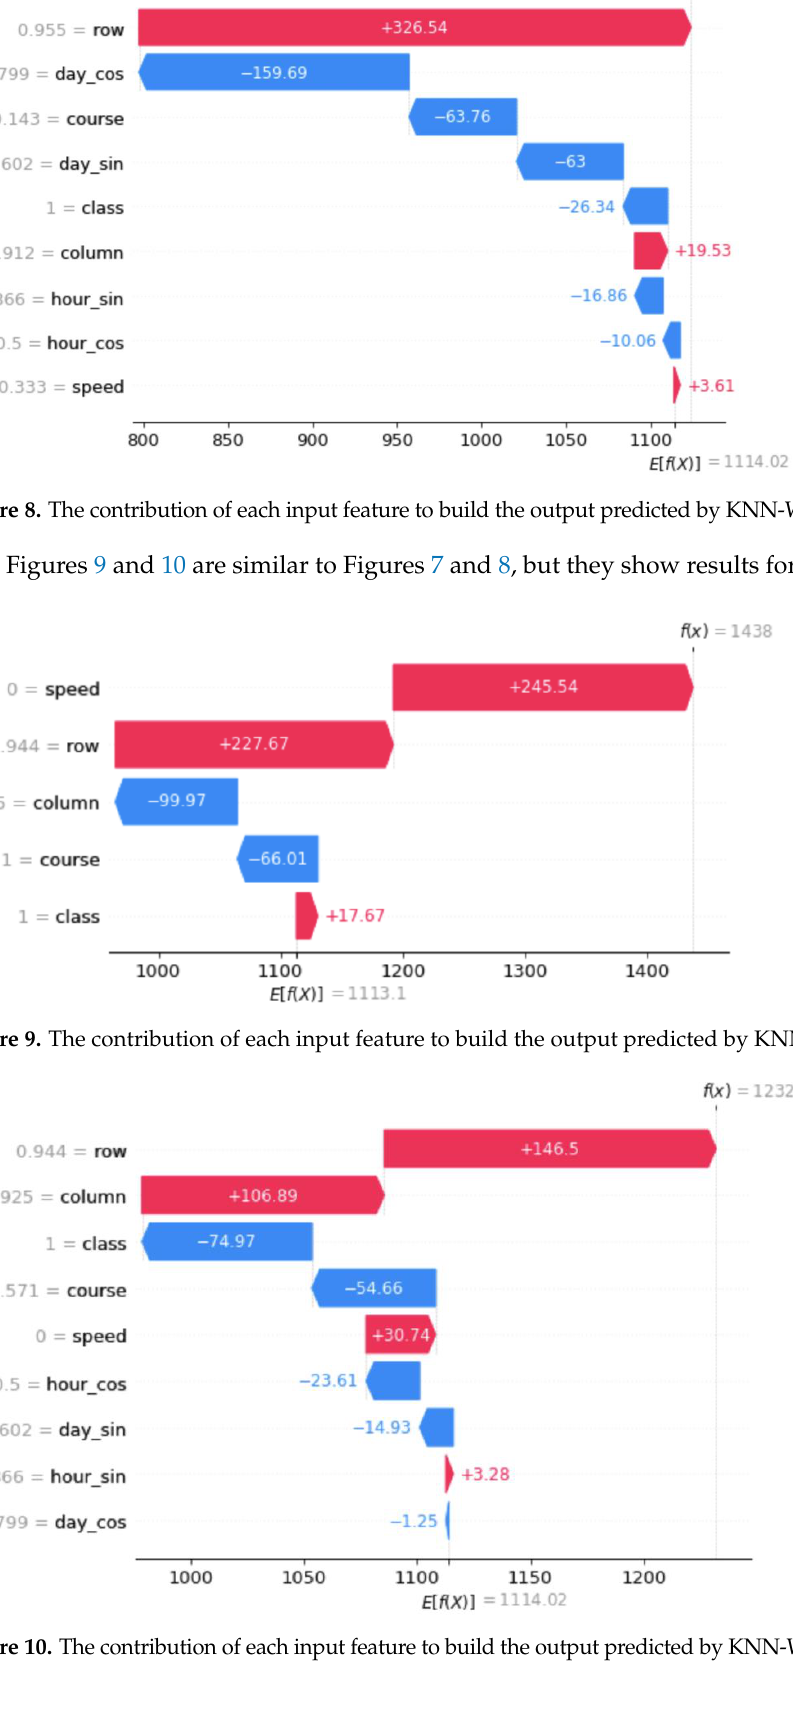
Figure 10. The contribution of each input feature to build the output predicted by KNN-WD for ship 81.